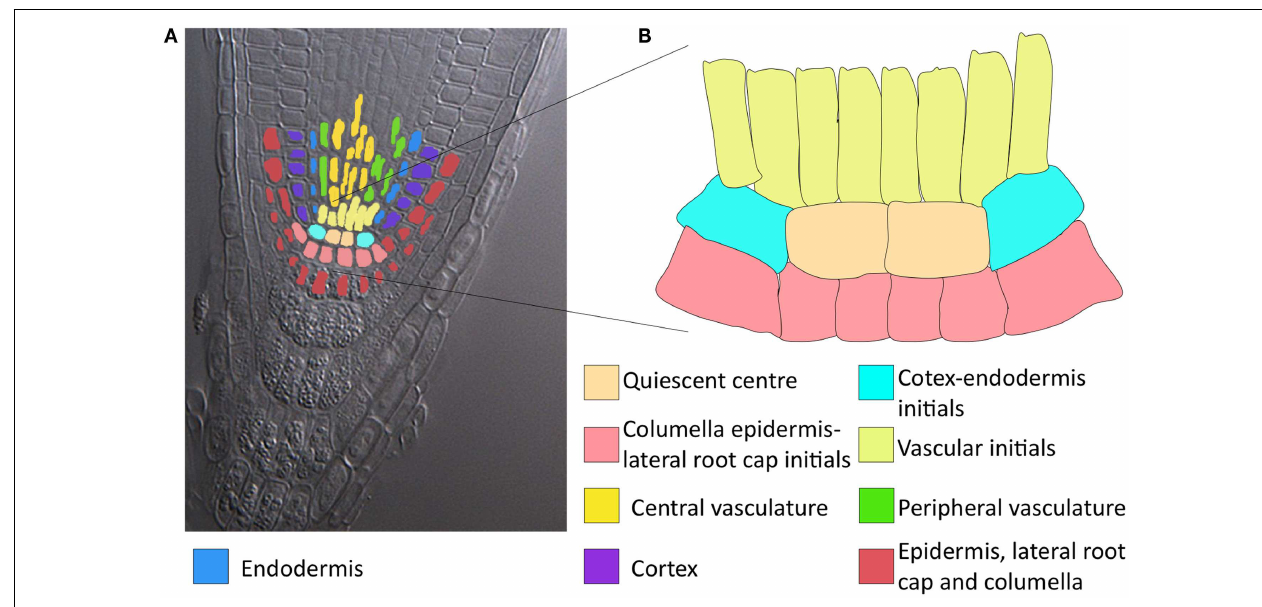
cellular type. QC, quiescent centre; END, endodermis;VI, vascular initials; CEI, cortex-endodermis initials; COR, cortex; PVC, peripheral vascular cells; CLEI, collumela-epidermis-lateral-root-cap initials; LCC, collumela and lateral root cap; and CVC, central vascular cells. (B) Amplification of the